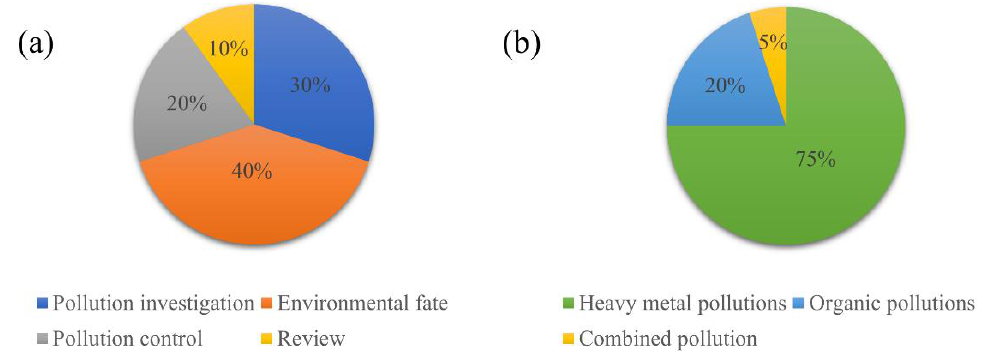
Figure 1. The classification of research in the Processes Special Issue: Advances in Remediation of Contaminated Sites. ( a ) the research fields, ( b ) the research object.